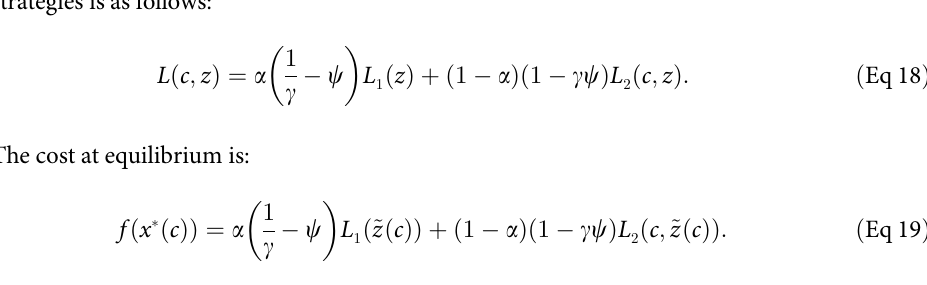
(cid:0) � = c holds. Parameters are G